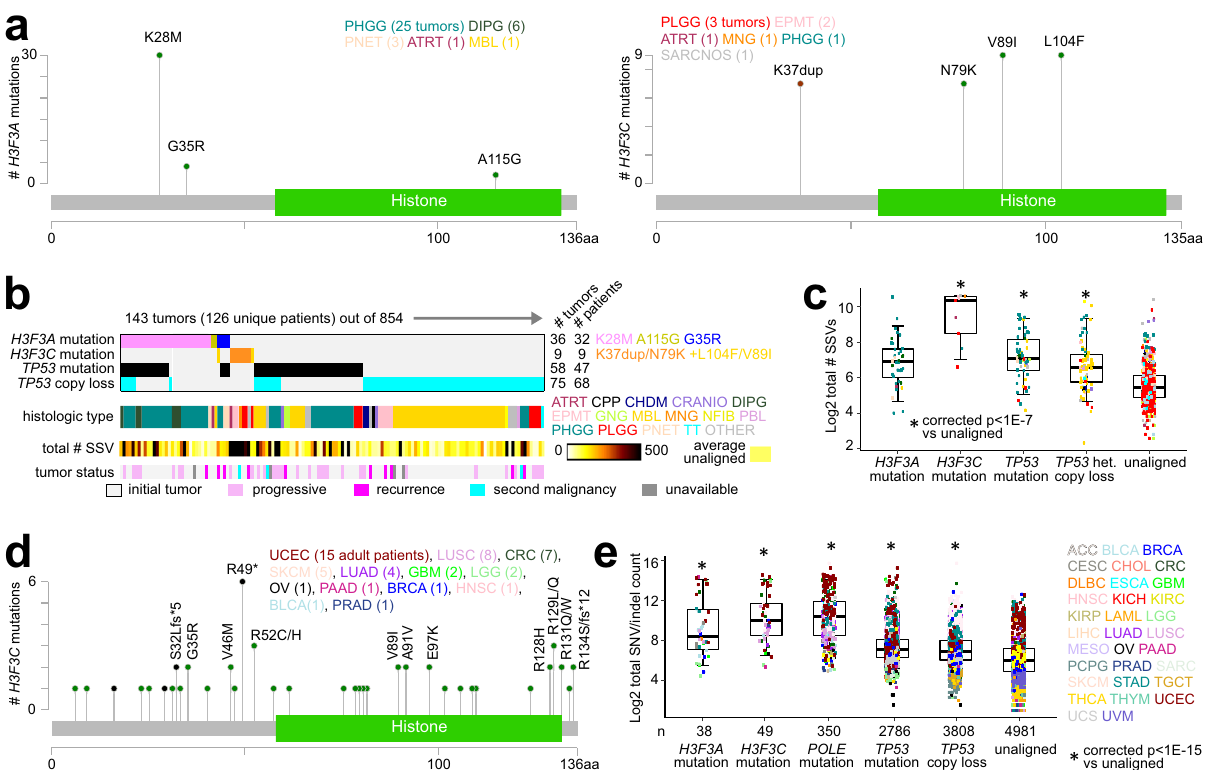
Fig. 8 Histone H3.3 somatic alterations in pediatric brain tumors include H3F3C mutations. a Prevalence and distribution of somatic SNVs or indels within H3F3A (left, involving 36 tumors and 32 patients) and H3F3C (right, involving nine tumors and nine patients), based on CBTCC tumors. b Across the 143 impacted CBTTC tumors, somatic mutations involving H3F3A , H3F3C , and TP53 , as well as TP53 copy loss. c For CBTTC cohort, associations of somatic alterations involving H3F3A , H3F3C , or TP53 with overall burden of SSVs. Numbers of tumors in each group from c , with 711 tumors in “ unaligned ” group. P values by linear model correcting for tumor type. d Prevalence and distribution of somatic SNVs or indels within H3F3C in TCGA adult pan-cancer cohort involving 49 patients (out of 10224 with whole-exome sequencing). e For TCGA cohort, associations of somatic alterations involving H3F3A , H3F3C , POLE 56 , or TP53 with the total number of detected exome SNV/indel mutations. P values by linear model correcting for tumor type. See Methods regarding tumor type abbreviations. Box plots represent 5% (lower whisker), 25% (lower box), 50% (median), 75% (upper box), and 95% (upper